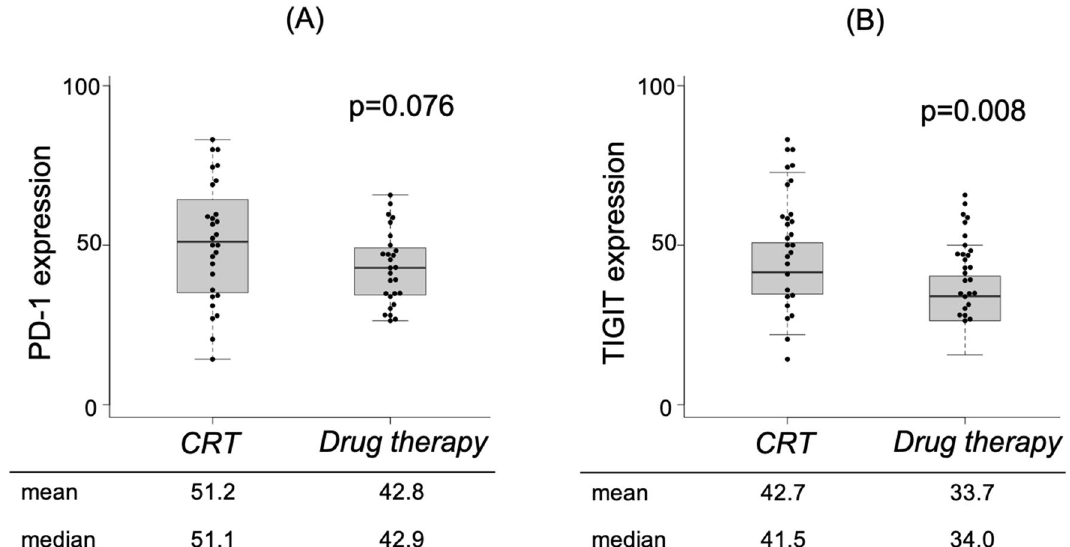
Figure 3. Expression rate of the TIL markers on CD8 + cells after induction therapy. The results are shown according to ( A ) PD-1 and ( B ) TIGIT